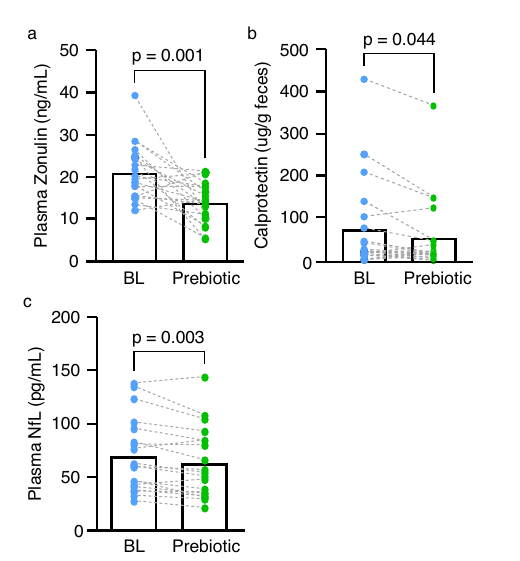
Fig. 4 | Ten days of the prebiotic intervention had effects on biological out- comes. Ten days of the prebiotic intervention: a reduced plasma zonulin n =20, b reduced stool calprotectin n =20, and c reduced plasma neuro fi lament (NfL) n =19. Bar height represents the group mean and individual points are indi- cated for each group, biological independent samples assessed at baseline and after the prebiotic intervention. A two-tailed, Paired t - test was used for analysis. Group means and standard deviations are shown in Table 3, and source data are provided as a Source Data File.